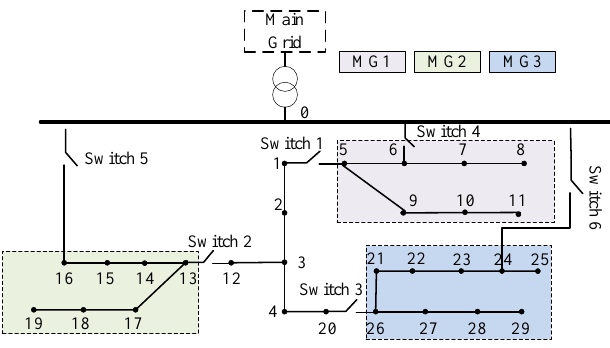
Figure 3. The proposed multi-microgrid (MMG) system. Table 1. System parameters.